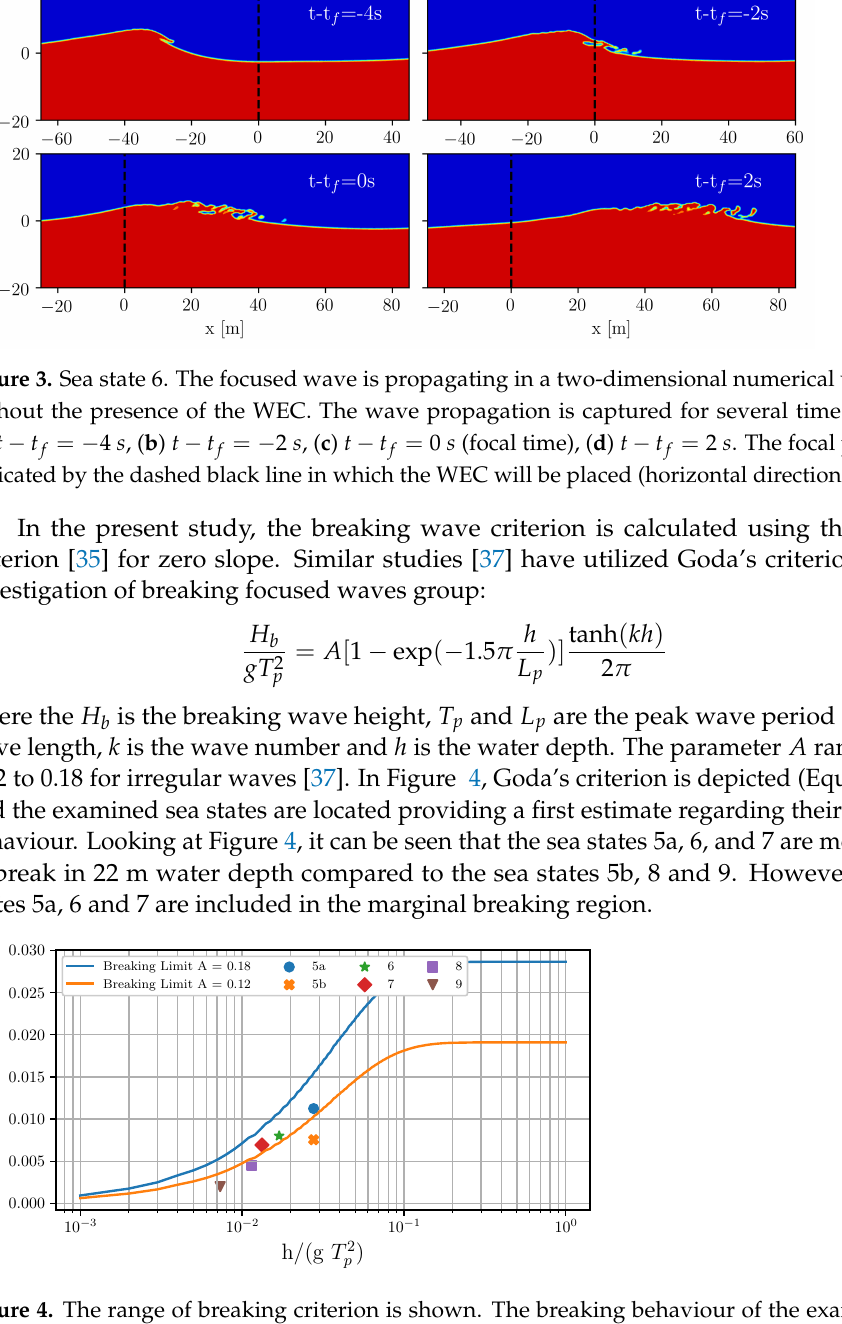
Figure 4. The range of breaking criterion is shown. The breaking behaviour of the examined sea states is